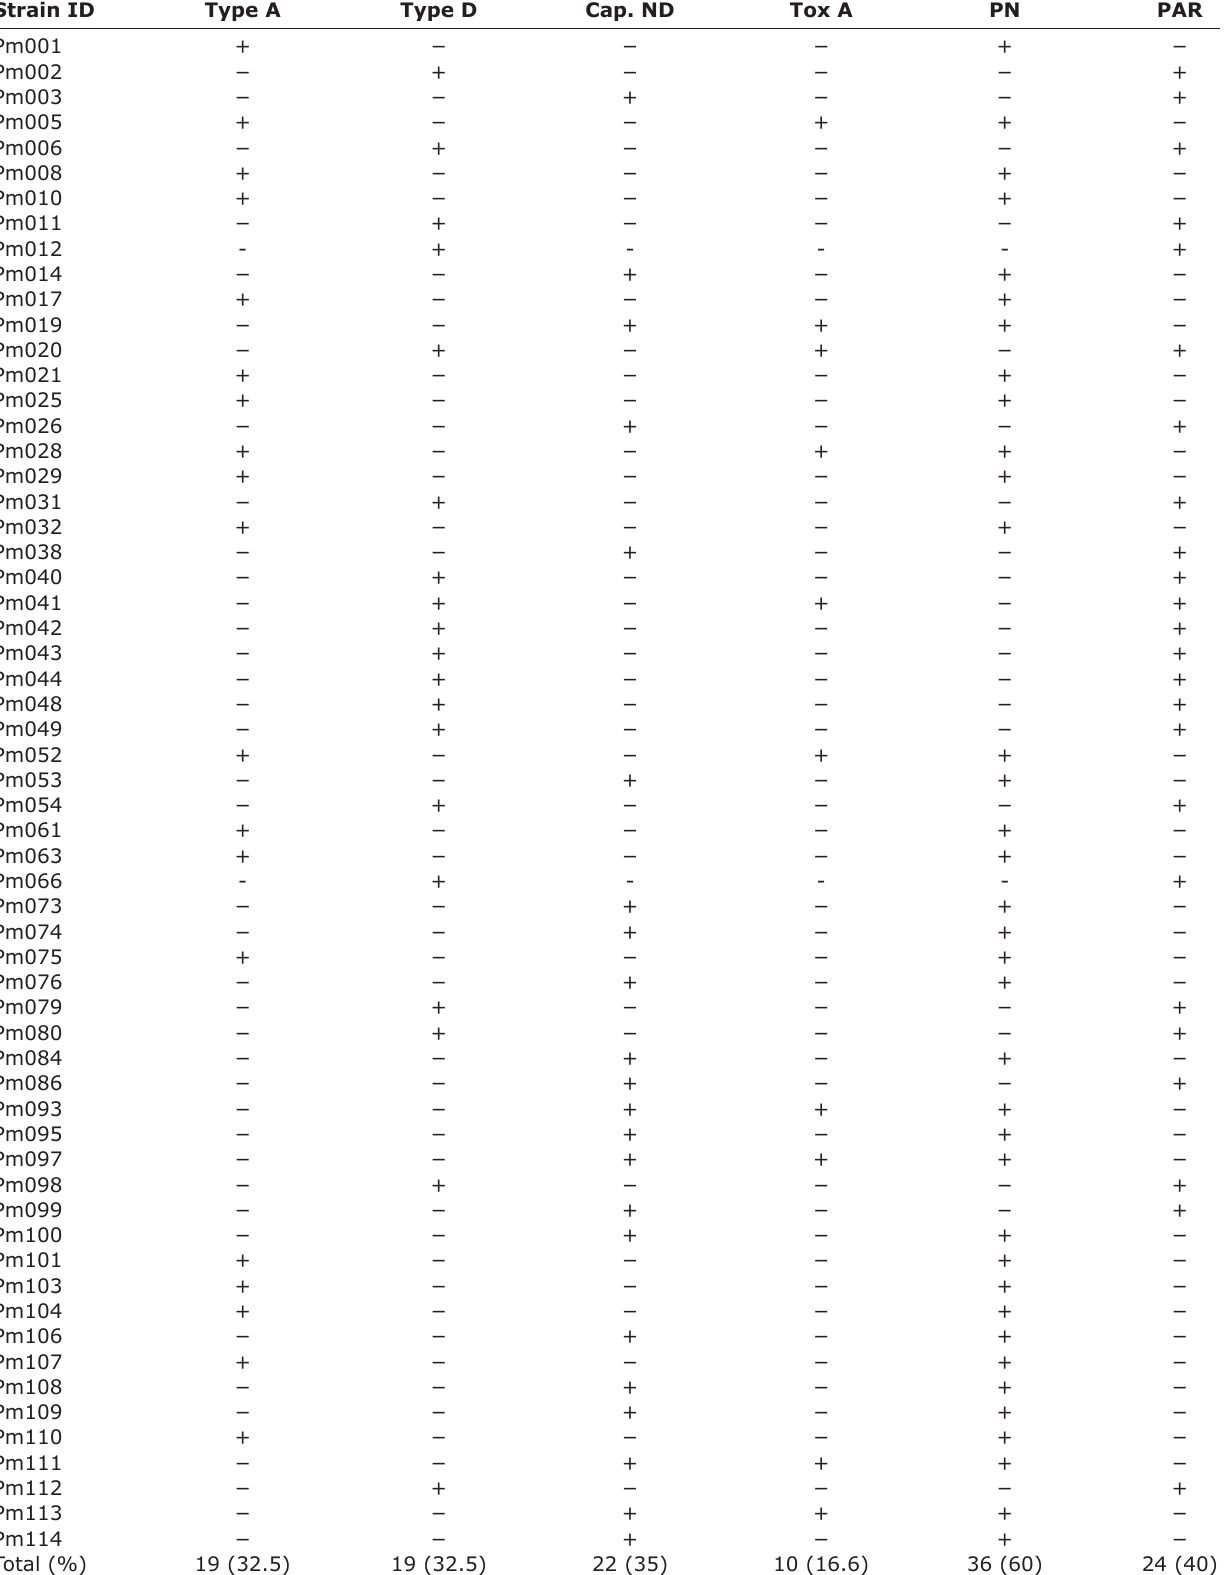
Table-2: Association of capsular types, presence of toxin, and pathogenicity of Pm isolates. Strain